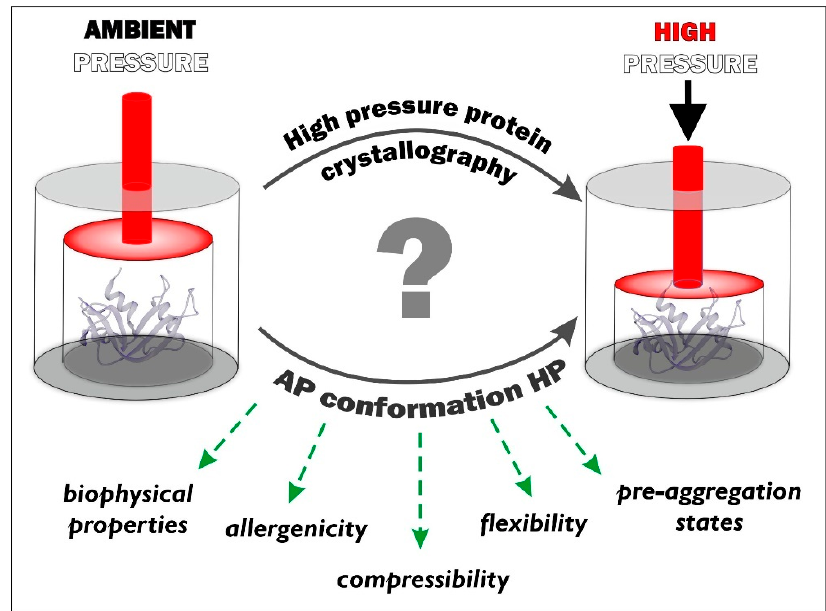
Figure 1. High pressure protein crystallography as a tool for investigation of macromolecular properties associated with high pressure conformation.